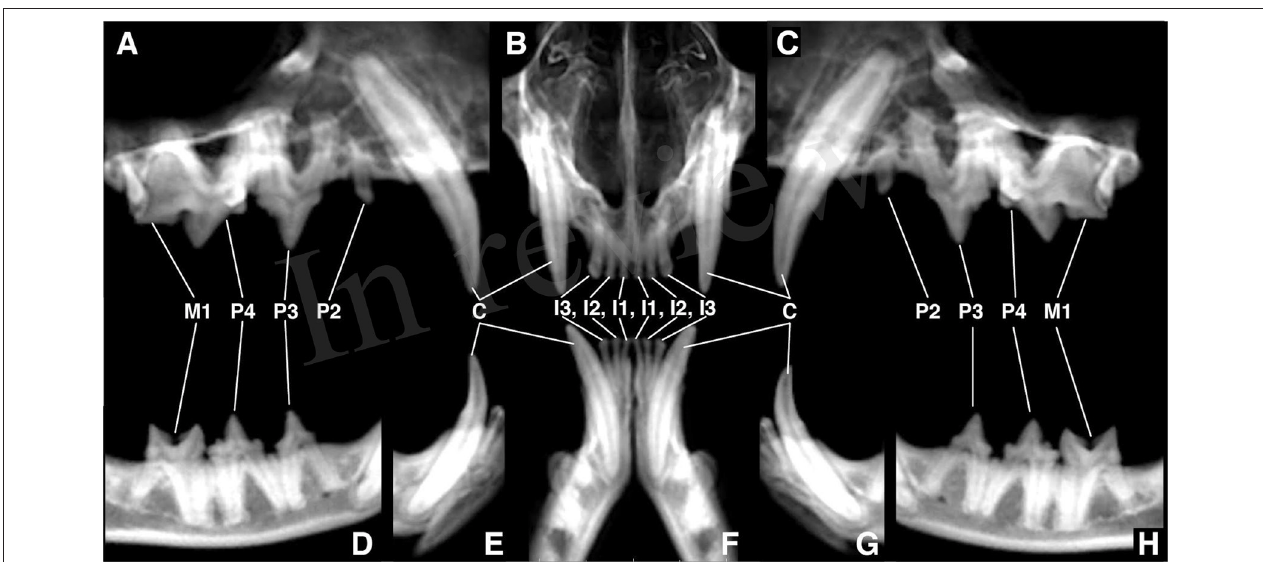
FIGURE 1 | Standardized reconstructed panoramic views for optimal evaluation of dentoalveolar lesions of cats. (A) axis of the skull adjusted for orientation of the right maxillary canine tooth through first molar tooth, (B) axis of the skull adjusted for orientation of the left and right maxillary first through third incisor teeth, (C) axis of the skull adjusted for orientation of the left maxillary canine tooth through first molar tooth, (D) axis of the skull adjusted for orientation of the right mandibular third premolar tooth through first molar tooth, (E) axis of the skull adjusted for orientation of the right mandibular canine tooth, (F) axis of the skull adjusted for orientation of the left and right mandibular first through third incisor teeth, (G) axis of the skull adjusted for orientation of the left mandibular canine tooth, (H) axis of the skull adjusted for orientation of the left mandibular third premolar tooth through first molar